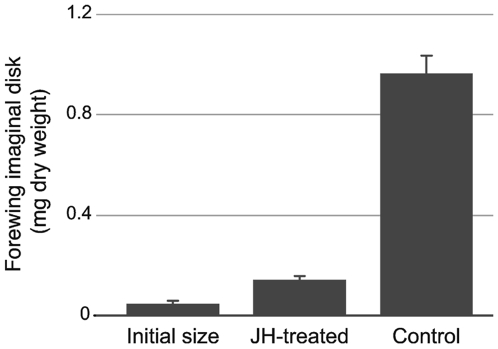
Effect of juvenile hormone on wing disk growth.Graph shows the size of the disks after 4 days for JH-treated larvae and acetone-treated controls. Each bar represents the mean of 6–8 larvae. Error bars SEM.